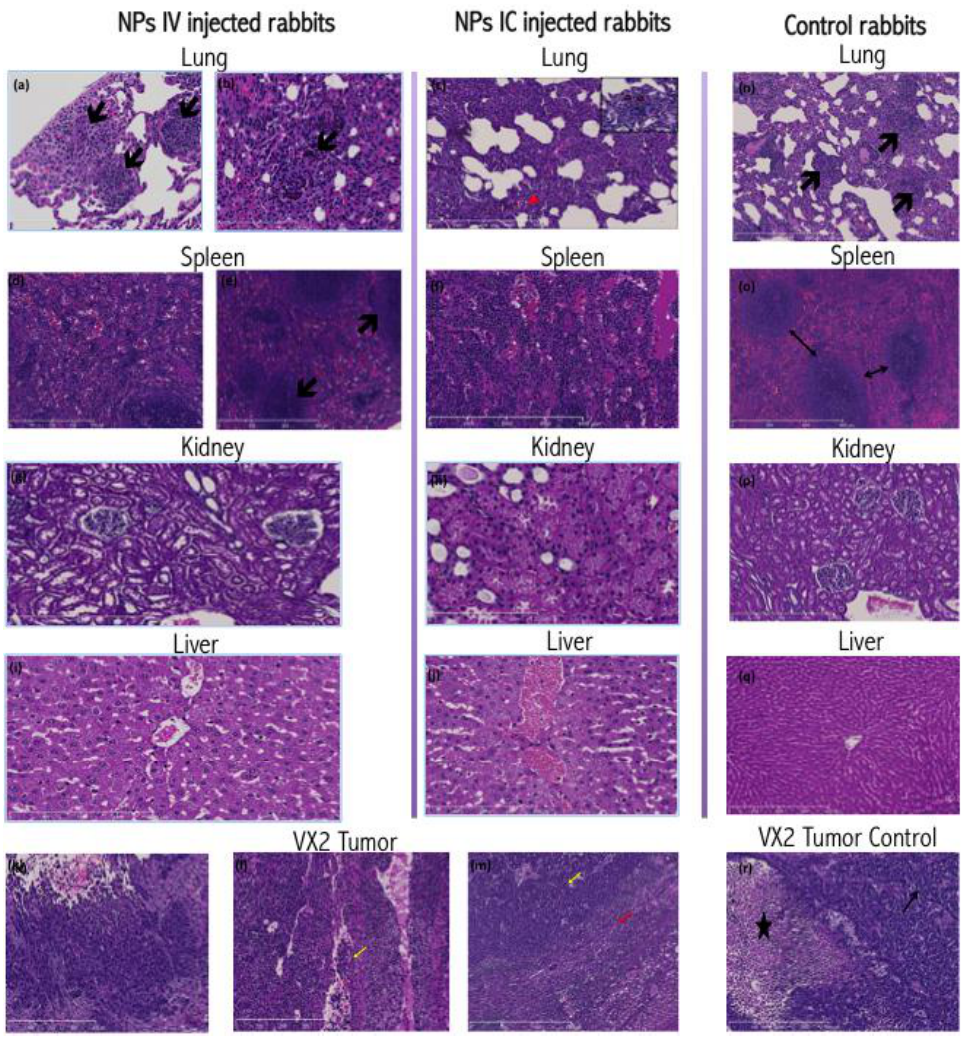
Figure 2. Details from Supplemental Figure S3. ( a ) IV injected rabbit’s lung showing metastatic nodular tumor deposits disposed in a peripheral location composed of poorly differentiated squamoid cells expanding the alveolar septae (100× H&E). ( b ) A photomicrograph of the IV injected rabbit lung showing alveolar septae expanded and infiltrated by inflammatory infiltrate, predominantly eosinophils (200× H&E). ( c ) IC rabbit lung showing marked thickening and destruction of alveolar spetae by metastatic deposits and inflammatory infiltrate composed mainly of granulocytes (arrowheads in inset, 400×). Blood vessels are engorged with granulocytes (arrow head). (100×). ( d , e ) IV injected rabbit’s splenic red pulp displaying dilated and congested sinusoids. Arrows point to follicles (100× H&E). ( f ) IC injected rabbit spleen showing congested and expanded red pulp with influx of macrophages and proliferated Littoral cells. ( g ) IV injected rabbit renal cortex showing mild to moderate cloudy changes in the tubules (100× H&E). ( h ) IC injected rabbit kidney showing cortical tubules exhibiting severe cloudy swelling and vesicular changes (100× H&E). ( i ) An IV injected rabbit liver micrograph displaying mild lobular disarray with hepatocyte ballooning (200× H&E). ( j ) IC injected rabbit’s liver showing dilated congested central veins and sinusoids. Hepatocytes show ballooning and microvesicular steatosis (200× H&E). ( k ) Photomicrograph showing part of VX2 tumor mass with a central necrotic cavity (100× H&E). ( l ) A photomicrograph of VX2 tumor showing infiltrating malignant cells on the left side, tumor infiltrating lymphocytes on the right, and a dilated sinusoid with tumor thrombus in the center (arrow) (100× H&E). ( m ) Photomicrograph of VX2 tumor showing nests of squamous cell carcinoma (yellow arrow), surrounded by a peripheral zone of tumor infiltrating lymphocytes (red arrow), compressed hepatocytes and fibroblasts; ( n ) Control rabbit